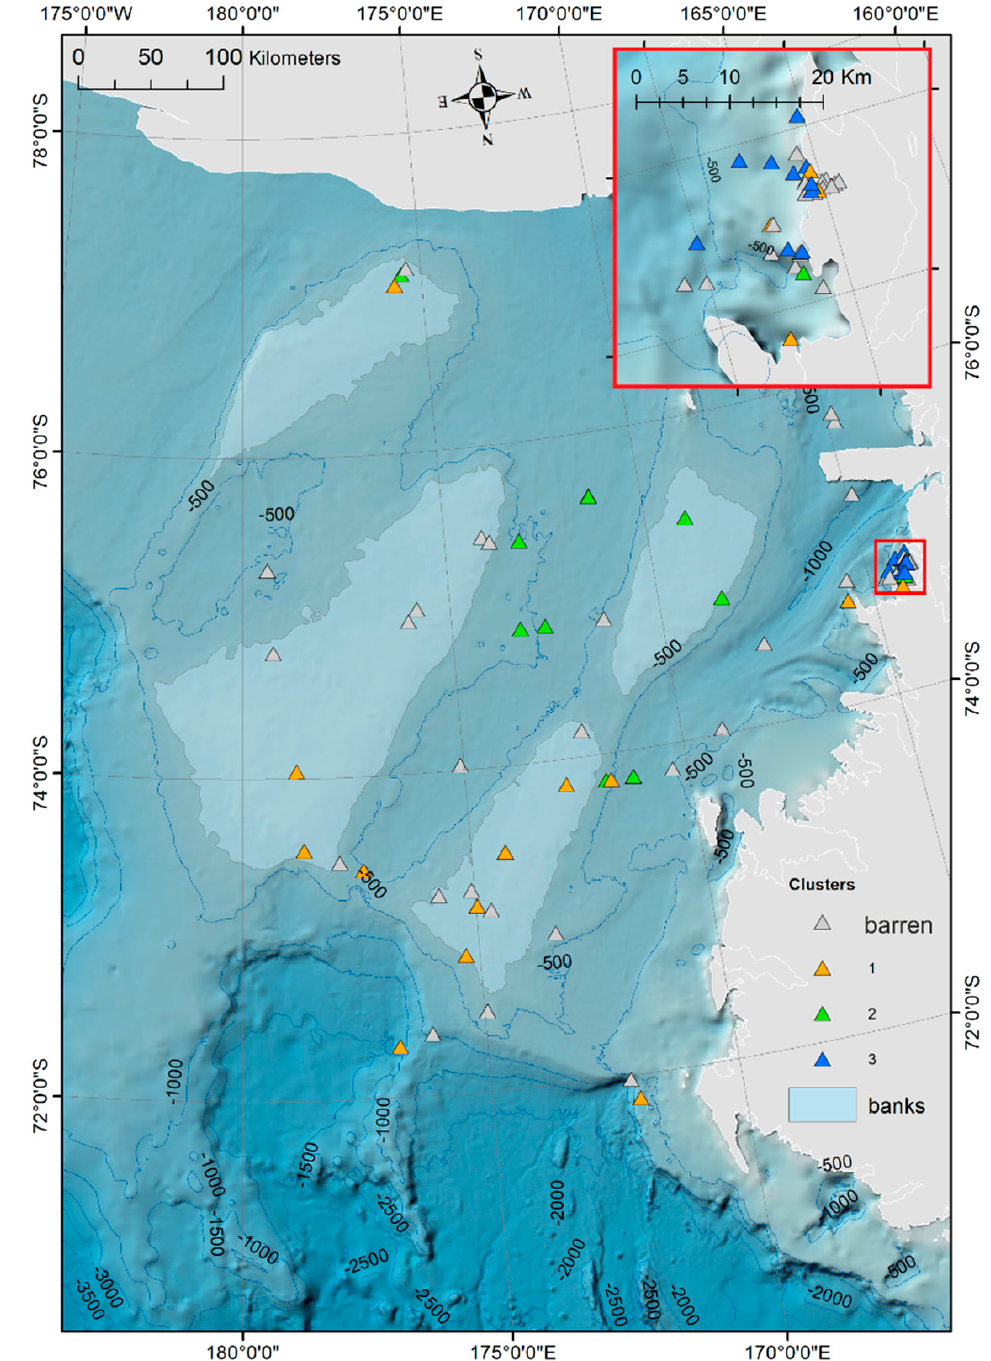
Figure 4. GIS predictive Q-mode cluster analysis distribution map interpolated in GIS, applying the spline method using barriers. Isobaths every 500 m.